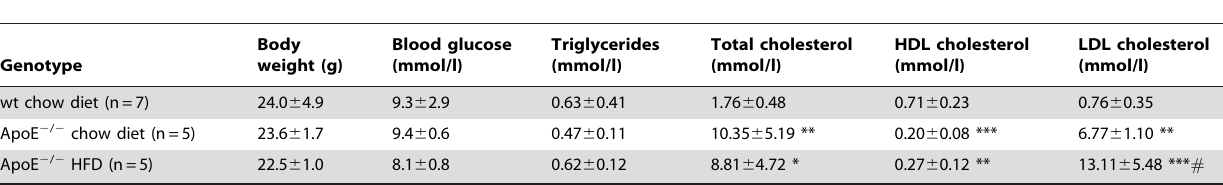
Table 2. Body weight, blood glucose, triglycerides, total cholesterol, LDL and HDL in wt and ApoE 2 / 2 mice, fed normal chow or HFD (experimental set 2).